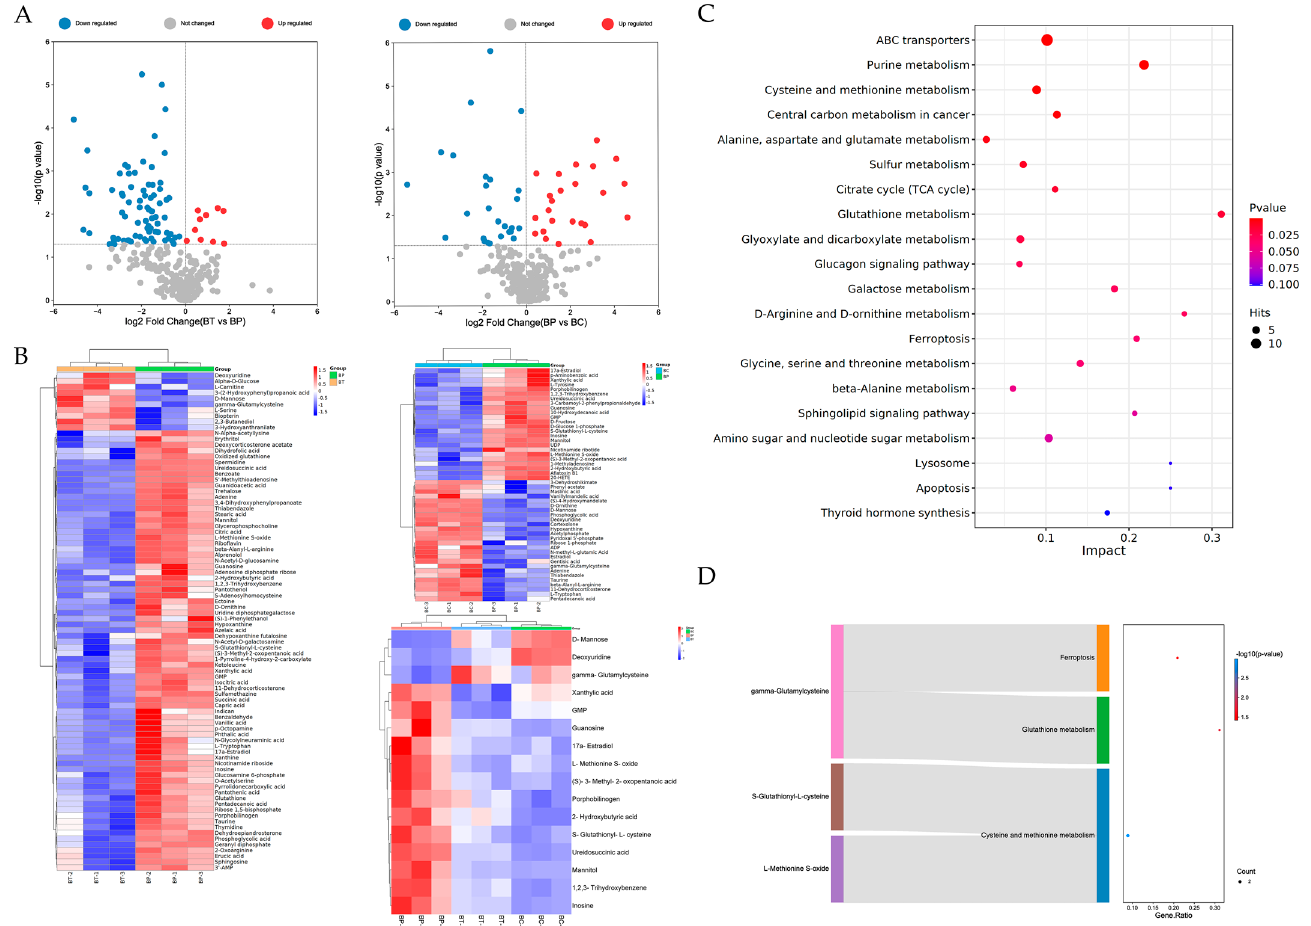
Figure 3. Metabolism analysis of catechin treating on macrophage RAW264.7 cells. ( A ) Volcano plots of differential metabolites in BT vs. BP group and BP vs. BC group. ( B ) Hierarchical cluster figures of differential metabolites. ( C ) Bubble diagram of metabolic pathways. ( D ) Metabolic pathways were related to ferroptosis and the enrichments of differential metabolites.